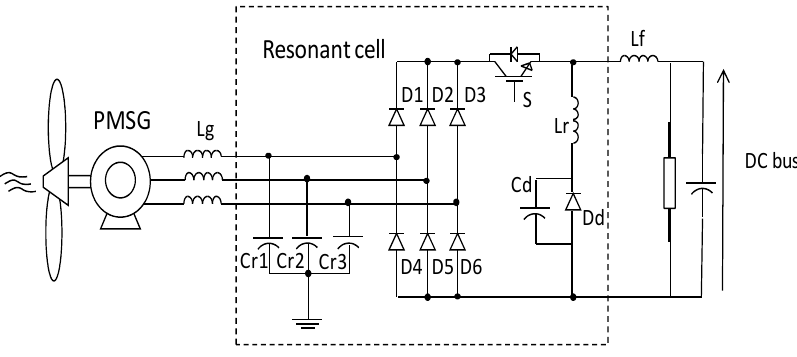
Figure 8. Single-switch 3-phase multi-resonant ZCS